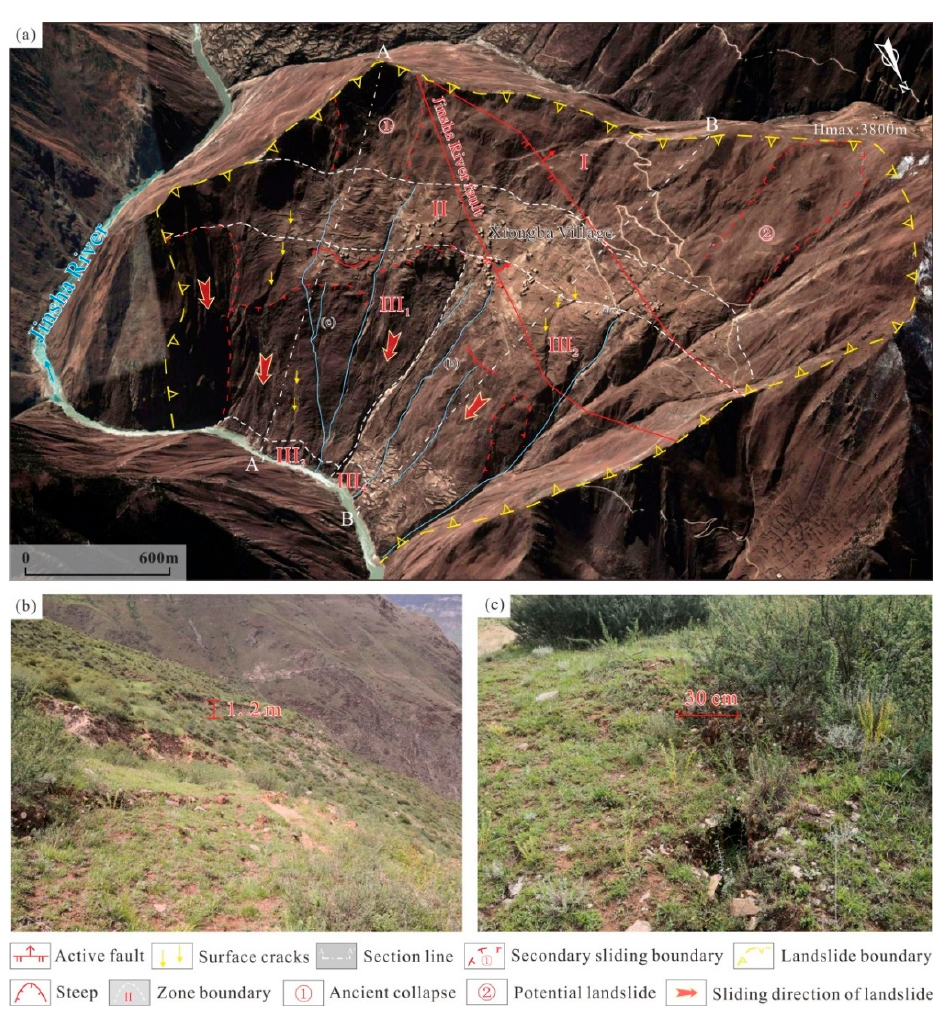
Figure 2. Remote sensing interpretation of the Xiongba ancient landslide and surface deformation feature map. ( a ) Remote sensing interpretation map of the Xiongba ancient landslide (base map according to Google Earth); ( b ) characteristics of the landslide front ridge and surface deformation (view to NW); ( c ) development characteristics of surface cracks in front of the landslide (view to